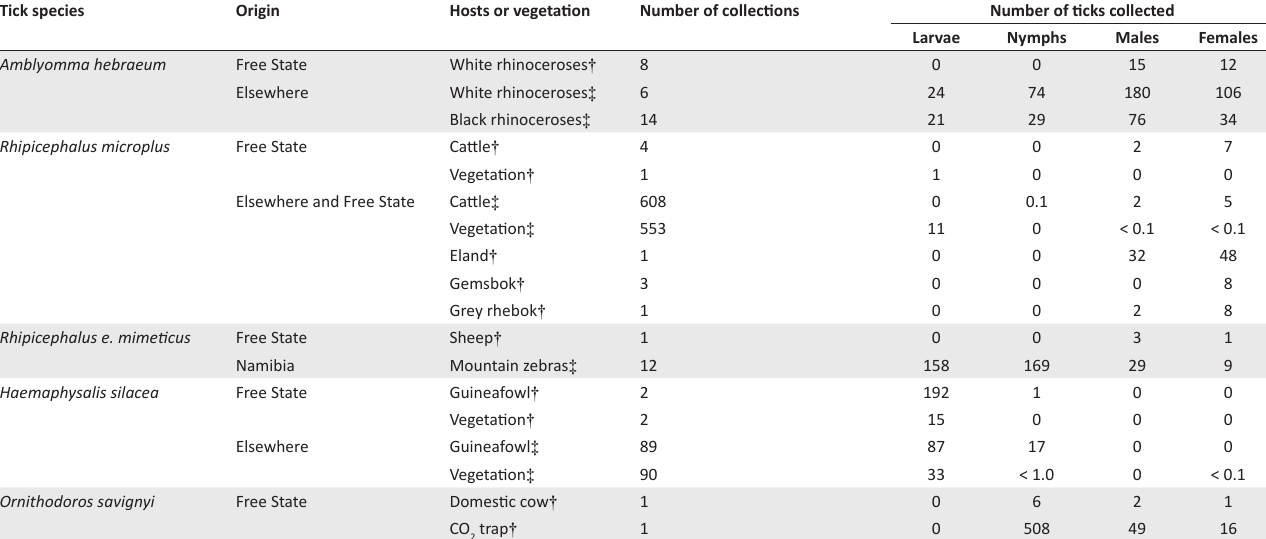
TABLE 2: Non-endemic tick species collected in Free State Province, South Africa and their hosts. Tick